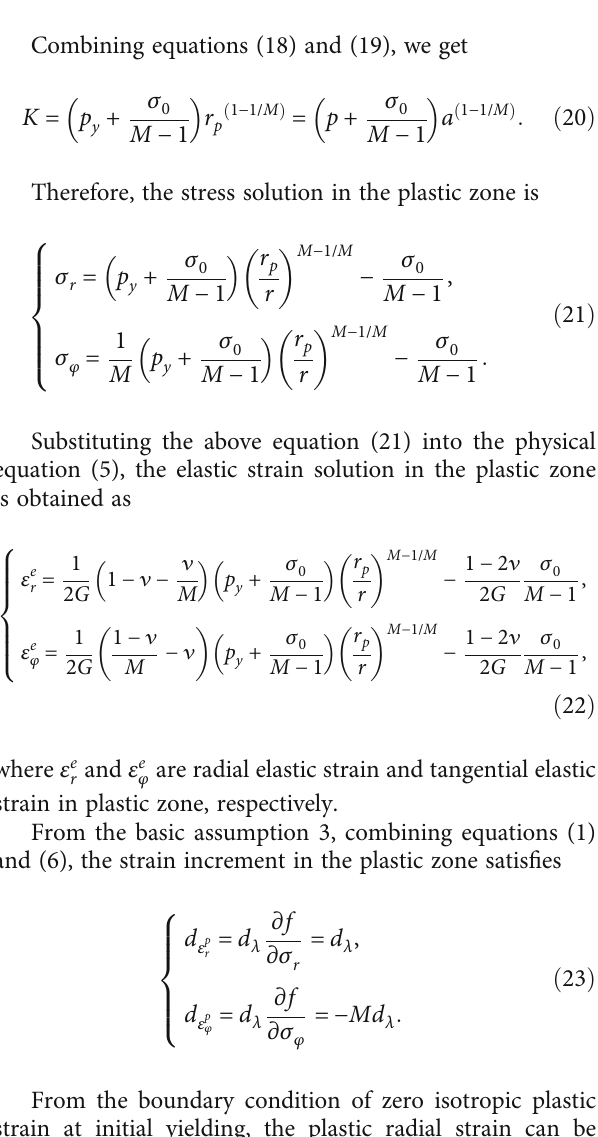
Figure 3: Mechanical model of radial expansion of slurry reaming. (a) Elastic stress in the whole region. (b) Elastic and plastic stress in the whole